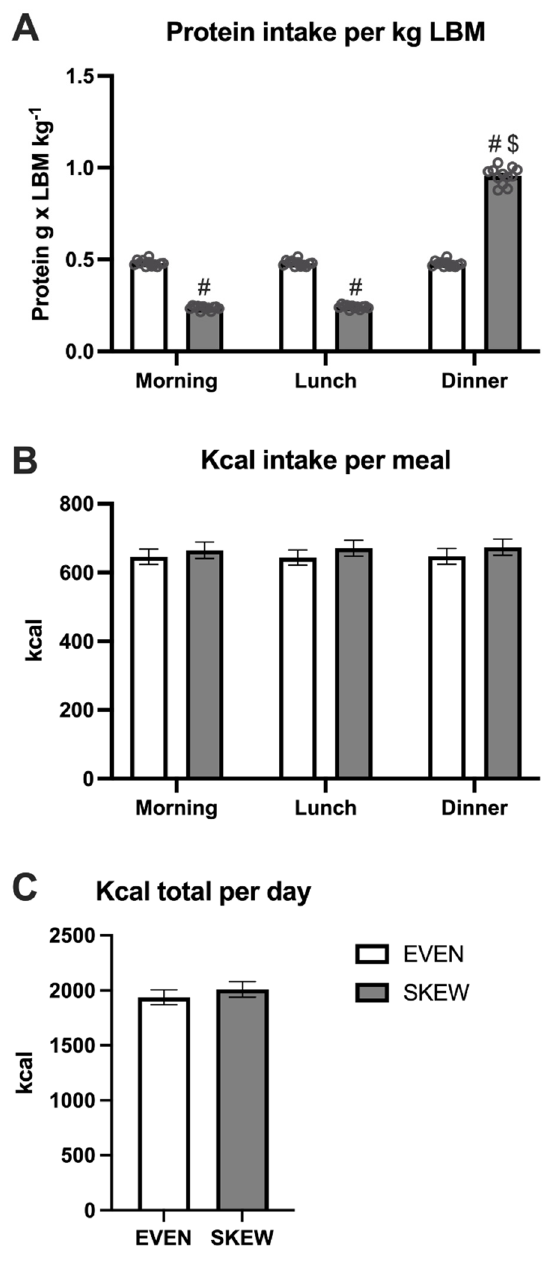
Figure 3. The daily intake of ( A ) protein per meal, ( B ) kcal per meal, and ( C ) total ingested kcal during the habituation period. 3A: No differences in protein intake per kg LBM were seen between meals in EVEN, whereas the intake was greater at dinner compared to breakfast ( p < 0.001) and lunch ( p < 0.001) in SKEWED. The protein intake per kg LBM was greater at breakfast ( p < 0.001) and lunch ( p < 0.001) in EVEN vs. SKEWED, whereas the intake at dinner were smaller at EVEN vs. SKEWED ( p < 0.001). 3B: No significant differences between the two groups or between meals were found for total kcal per day. 3C: The total daily calorie intake was the same for the EVEN and SKEWED group. Data shown as mean ± SEM. # denote different from EVEN, $ denote different from breakfast and lunch.